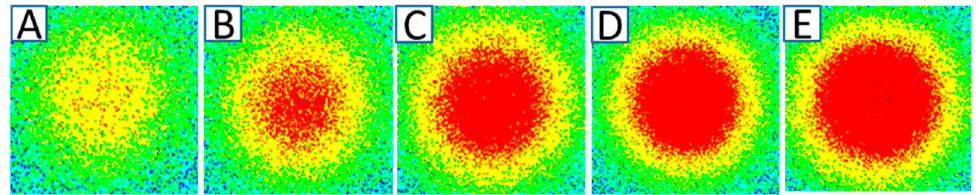
Figure 4. Autoradiographs of the mixture of 239 Pu, 241 Am, and 244 Cm alpha sources electro-precipitated in 0.3 M Na 2 SO 4 at pH 3.50 electrolyte solutions with a current density of 5 mA.cm − 2 onto BDD substrates at different precipitation times: ( A ) 15 min; ( B ) 30 min; ( C ) 60 min; ( D ) 90 min; and ( E ) 120 min.